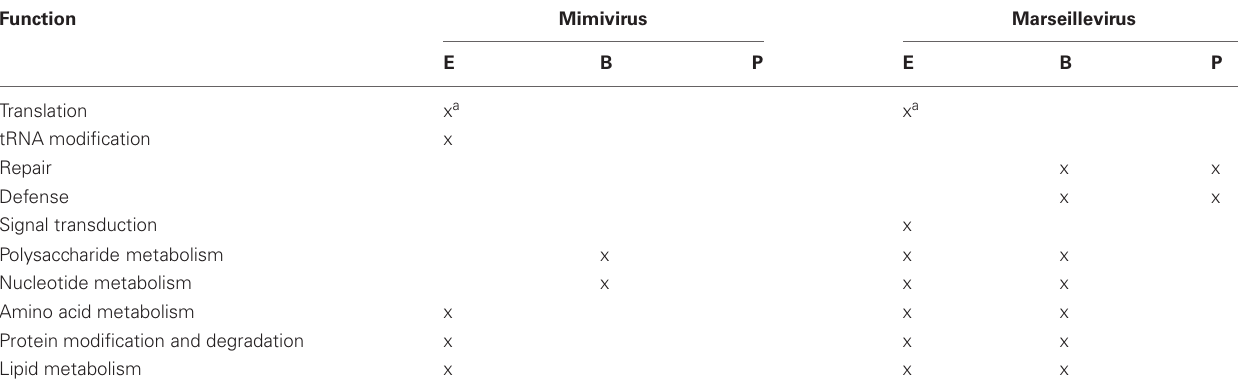
Table 6 | Function and origin of LGTs in amoeba-resisting viruses.